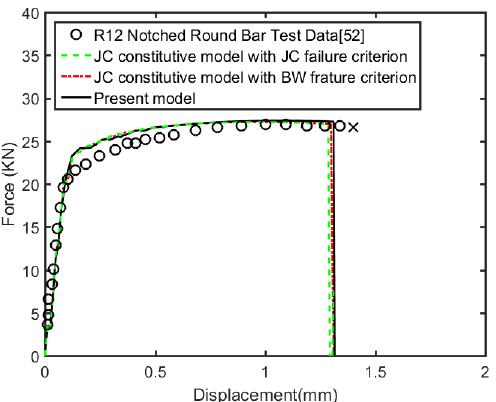
Figure19. Comparisonsbetweenthemodelpredictionsandtheexperimentaldataforload-displacement Figure 19. Comparisons between the model predictions and the experimental data for curve for 2024-T351 aluminum alloy R12 notched round bar tension load-displacement curve for 2024-T351 aluminum alloy R12 notched round bar tension test.